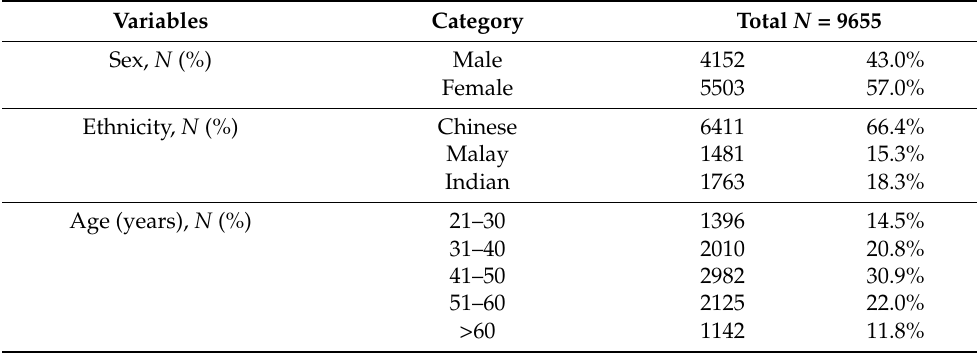
Table 1. Baseline characteristics of Singapore Multi-Ethnic Cohort participants aged 21 years and